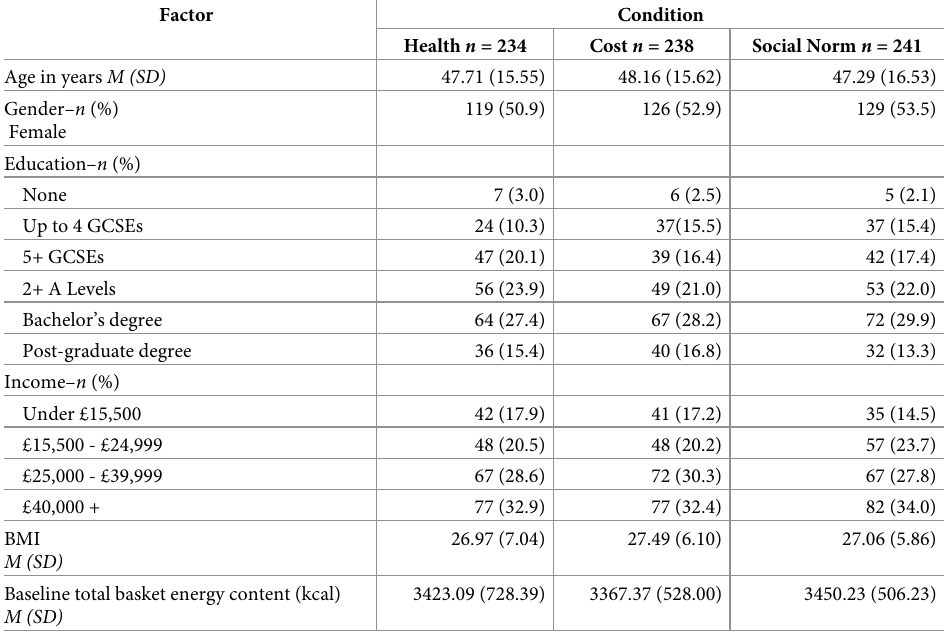
Table 1. Randomisation checks and distribution of baseline and demographic characteristics between